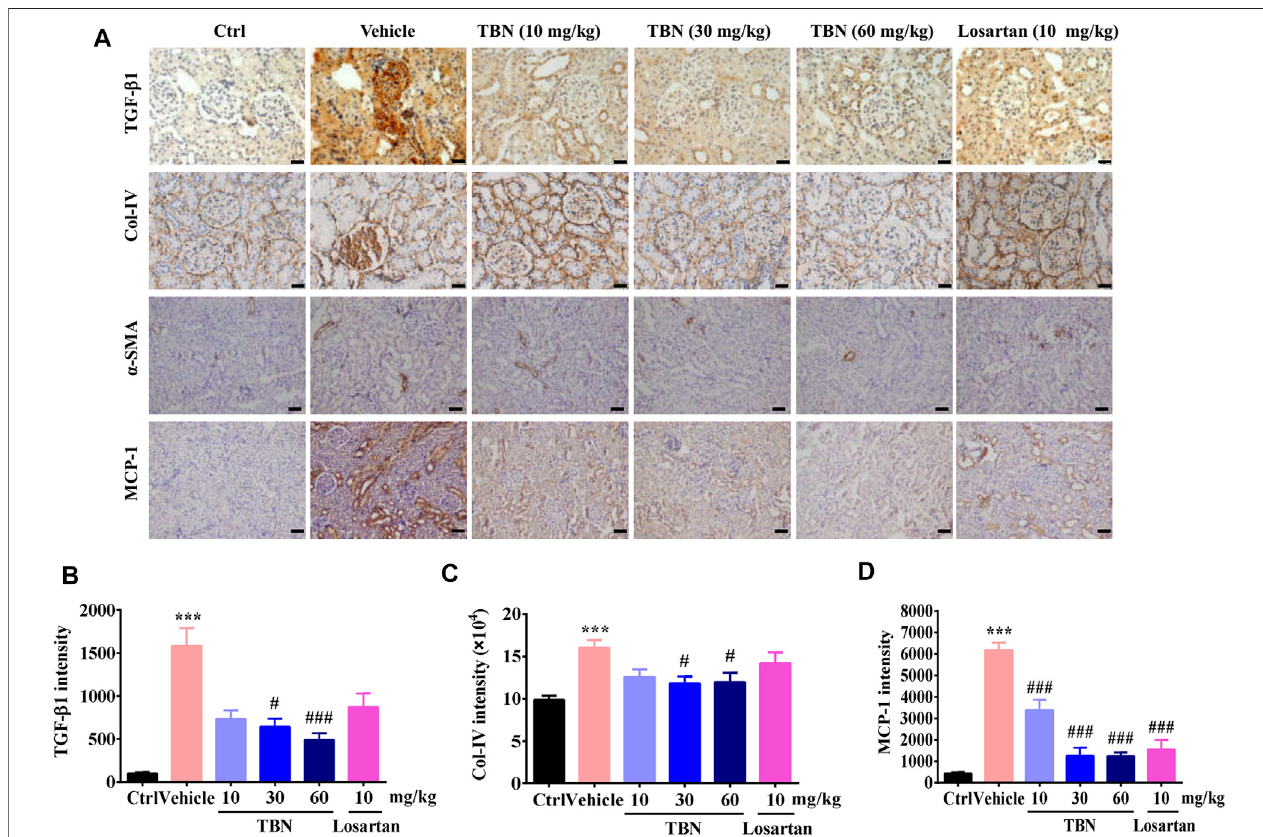
FIGURE 3 | TBN Reduces fi brosis and interstitial in fl ammation in Renal Tissue of STZ-treated Rats. (A) Representative immunohistochemical images of TGF- β 1, Col-IV, α -SMA, and MCP-1 staining. Immunohistochemistry staining of TGF- β 1 and Col-IV was observed under 400 × phase contrast microscope. Immunohistochemistry staining of α -SMA and MCP-1 was observed under 200 × phase contrast microscope. (B-D) Semi-quantitative analysis of TGF- β 1, Col-IV, and MCP-1 immunostaining intensity in the kidney for different groups were shown. Brown staining indicates the immunopositive area for the protein of interest. 30 imagesofimmunostainingsectionswerecountedforeachrat. n (cid:1) 13forvehicle-treatedDMgroupand n (cid:1) 16forothergroupsinTGF- β 1immunostaining. n (cid:1) 8foreach group in Col-IV immunostaining. n (cid:1) 5 for each group in MCP-1 immunostaining. Data were expressed as means ± SEM and were analyzed by 1-way ANOVA with Tukey ’ s test. ** p < 0.01 and *** p < 0.001 vs. Ctrl group. # p < 0.05, ## p < 0.01, and ### p < 0.001 vs. vehicle-treated